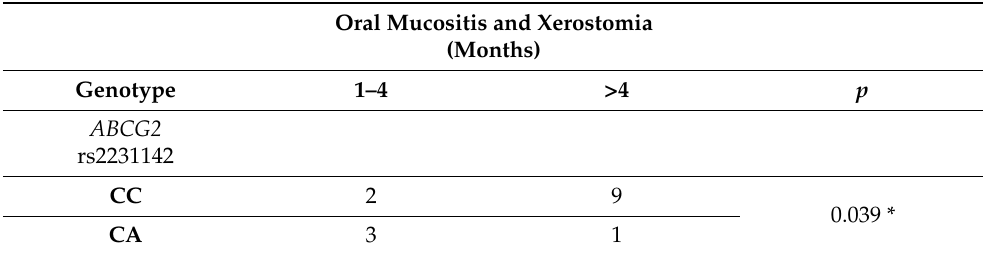
Table 7. Genotype associated with the duration of the maximum grade of mucositis and xerostomia at genotype level for rs2231142 in ABCG2 gene. p < 0.05 with χ 2. Oral Mucositis and Xerostomia (Months) Genotype 1–4 >4